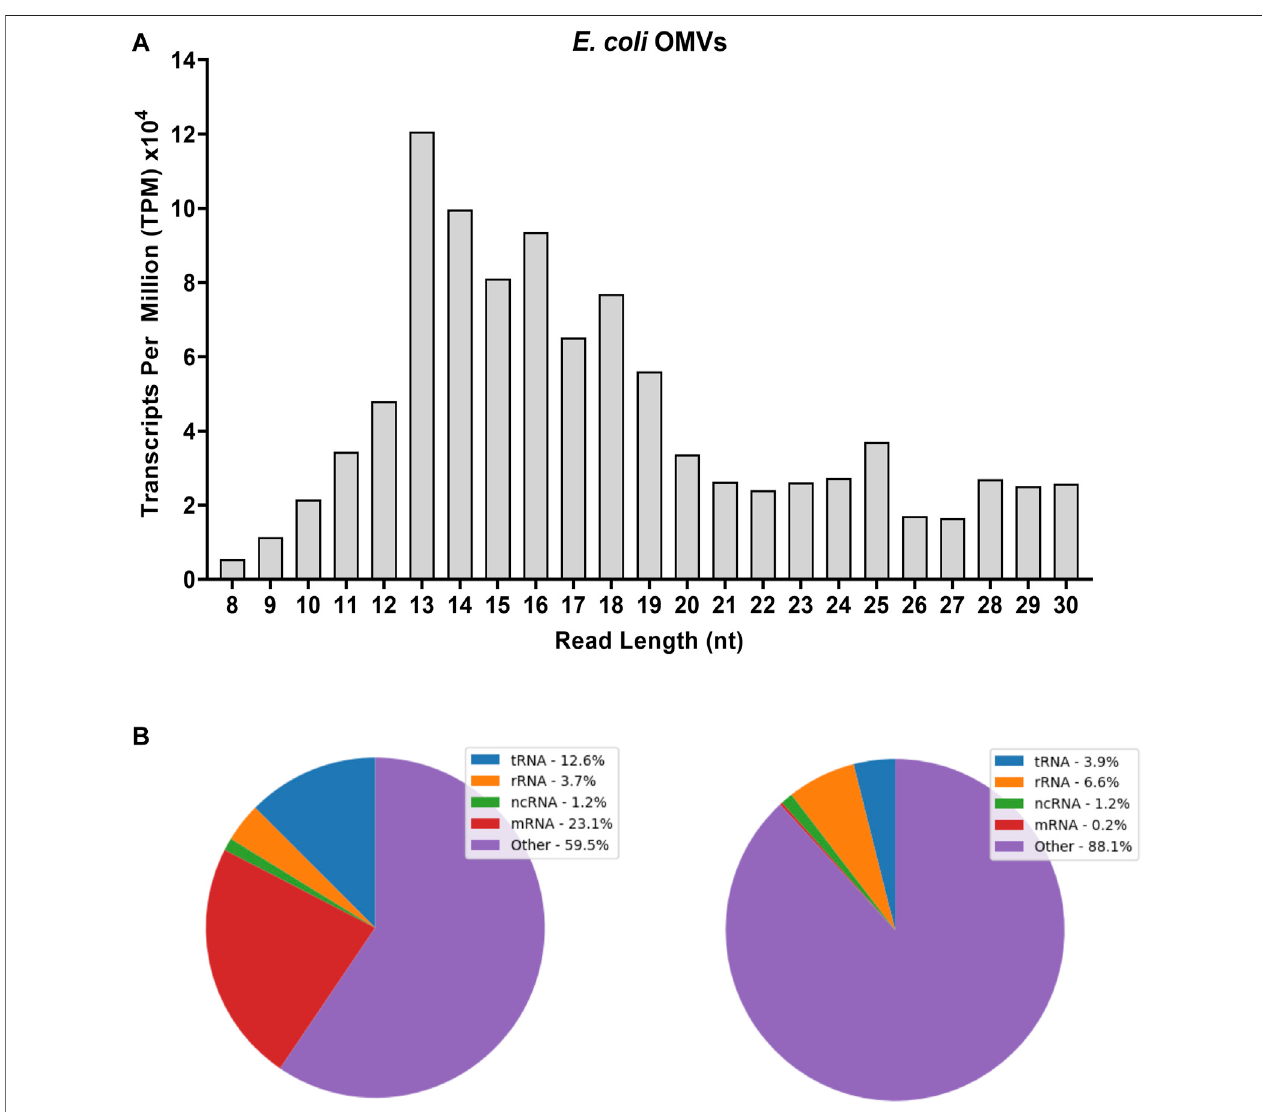
FIGURE 4 | Adapter-trimmed reads length (8 – 30 nt) and biotypes distribution in E. coli -derived OMVs. Small RNA-Seq analyses in the 8 – 30 nt window of OMV sample. (A) Total adapter-trimmed read counts expressed in TPM. (B) Annotated sRNA sequencing reads were classi fi ed by RNA-type after alignment to E. coli genome. “ ncRNA ” refers to all non-coding RNAs except tRNAs and rRNAs; “ other ” refers to all other RNA fragment that do not derive from a mRNA or ncRNA. Puri fi ed OMVs were obtained with the Exobacteria kit (For details, see Materials and Methods ).